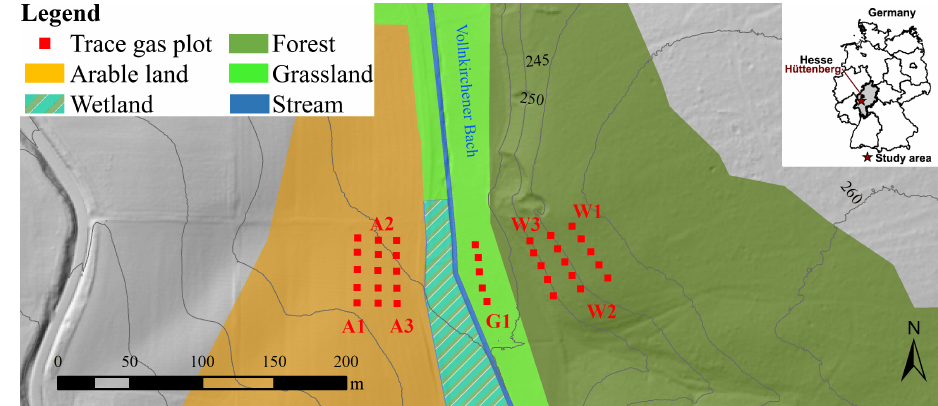
Figure 1. Map of the study area. Red squares represent GHG chamber positions at the different transects. Dark grey contour lines represent 5m differences in elevation. Light grey areas are outside of the catchment